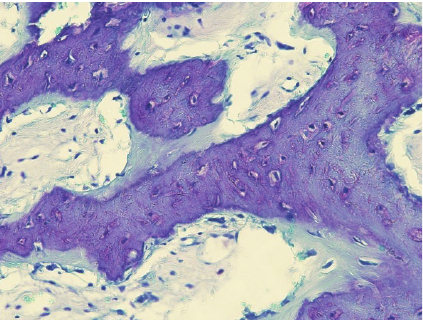
Figure 9: Under high magnification, newly formed lamellar bone surrounding the woven bone was confirmed (toluidine blue stain-